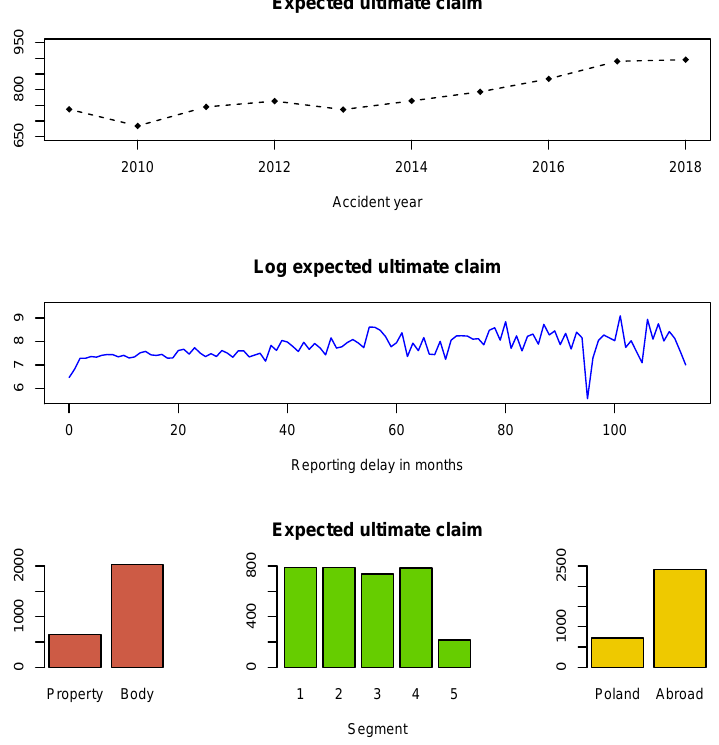
Figure 3. Expected aggregate ultimate payments from an individual claim.